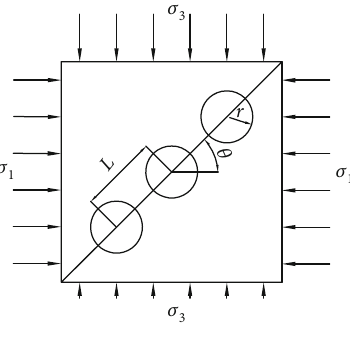
Figure 1: Geometric